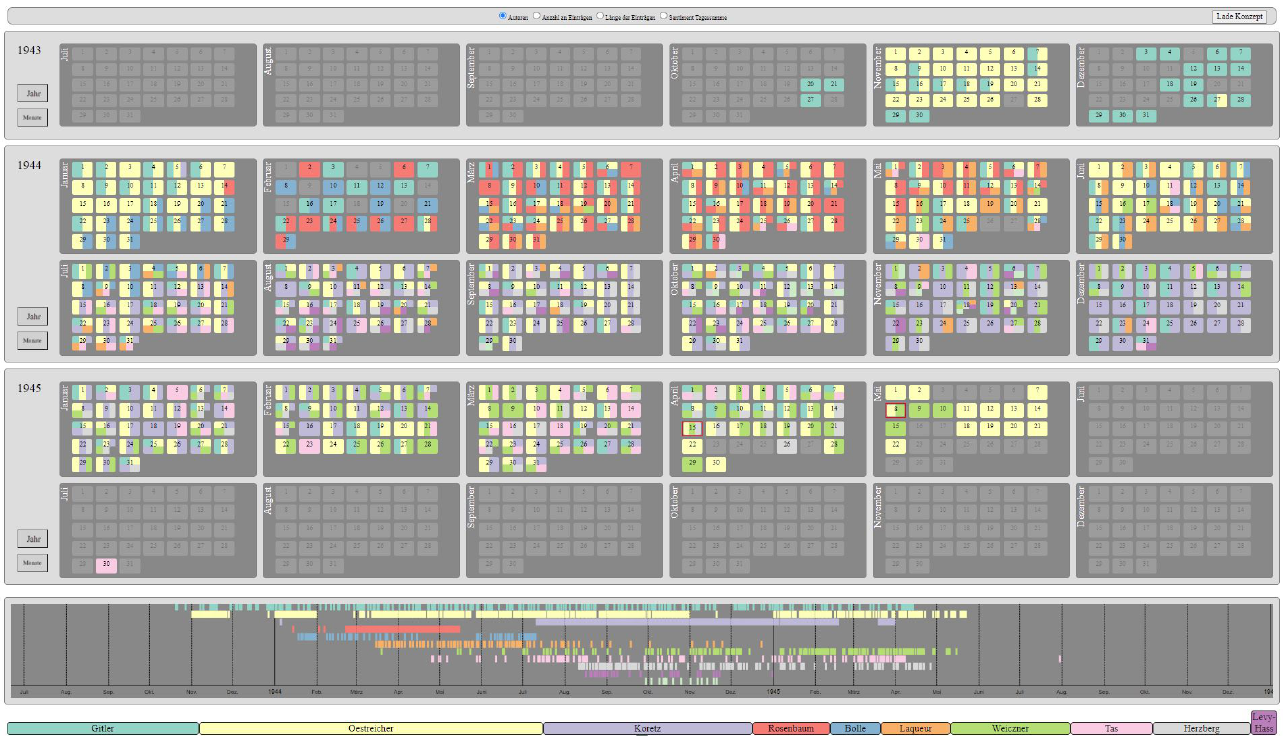
Figure 2. Overview of diaries in the tool. From top to bottom: a mode selection menu, the calendar, the timeline, and the